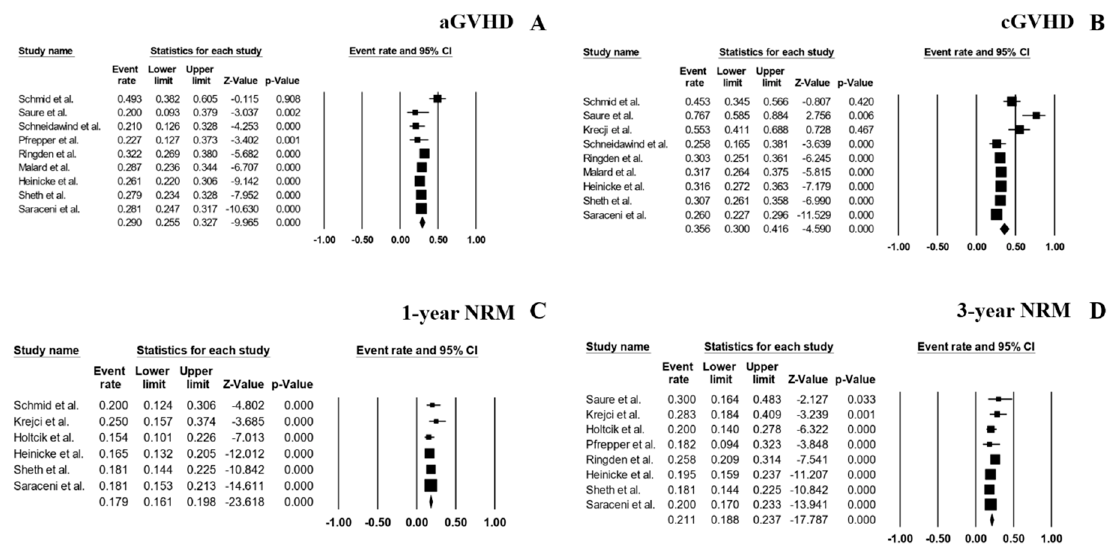
Figure 4. Forest plots of pooled estimates ( 95 % CI ) for complications after HSCT; ( A ) : Acute graft - versus - host disease (aGVHD); ( B ) : Chronic graft - versus - host disease (cGVHD); ( C ) : 1 - year non - relapse mortality ( NRM); ( D ) : 3 - year NRM .